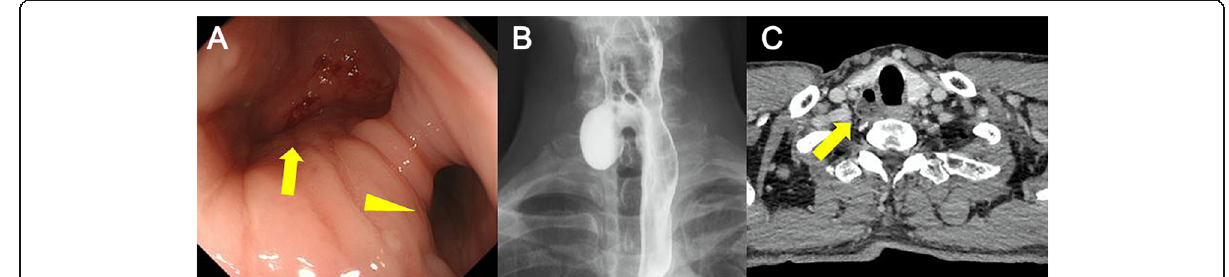
Fig. 1 a Upper intestinal endoscopy shows a diverticulum (yellow arrow) and the true lumen of the esophagus (yellow arrowhead). b Esophagogram shows a right-sided outpouching sac from the esophagus. c Computed tomography with contrast shows diverticulum from the esophagus at the level of the cricothyroid cartilage